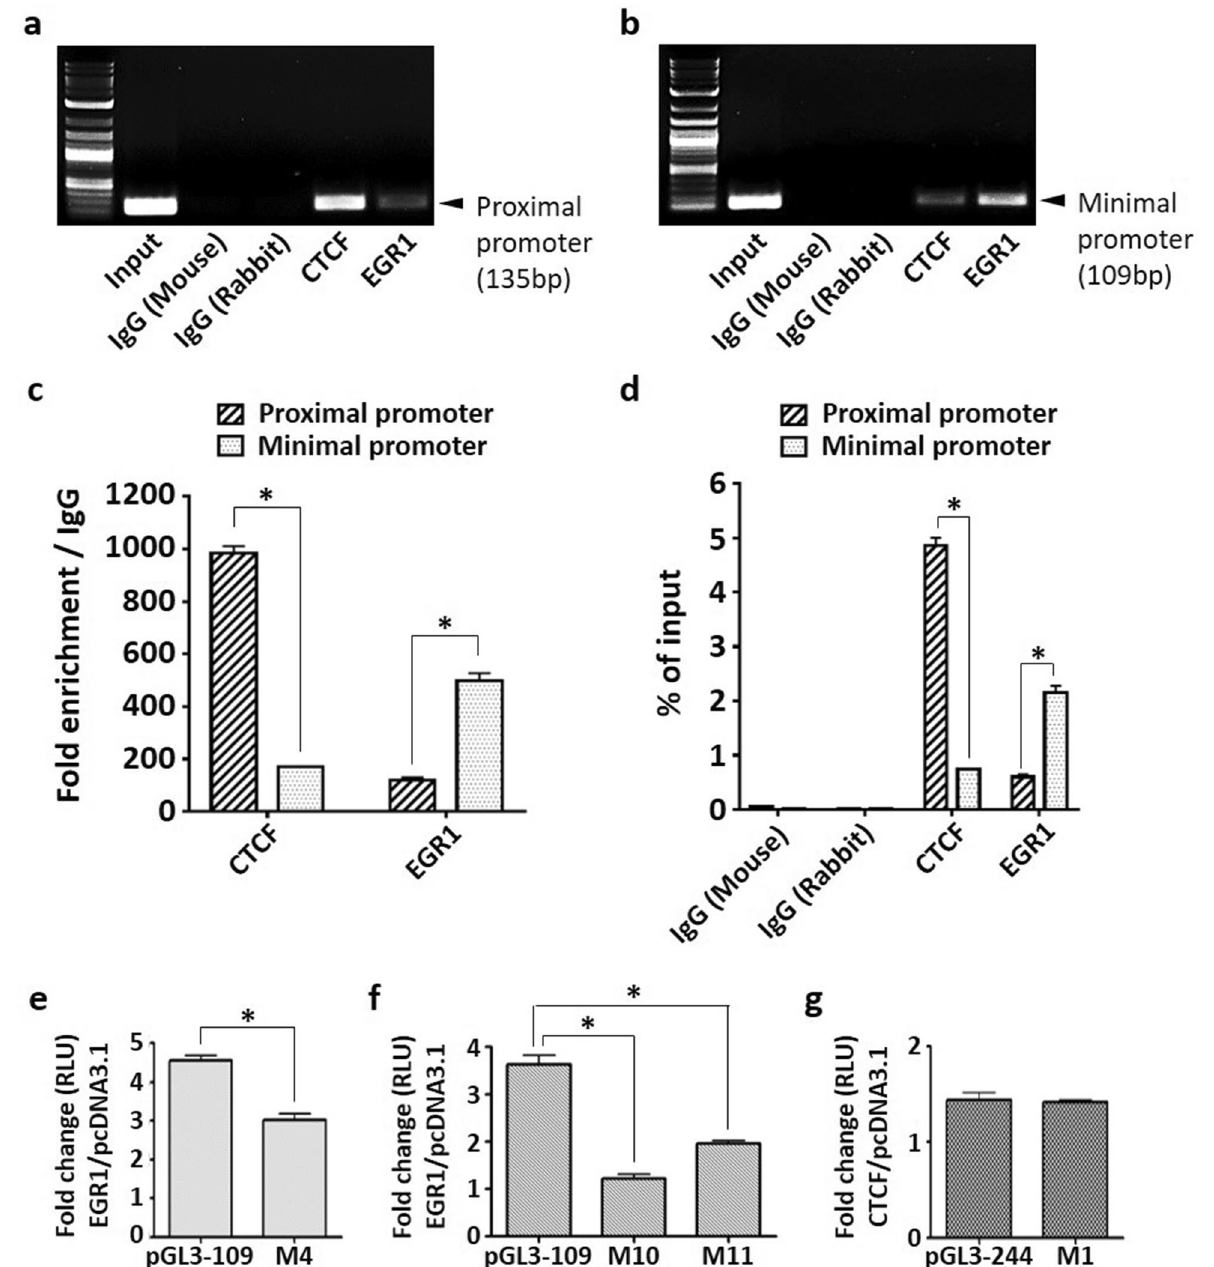
Figure 5. Binding of EGR1 to the NME1 proximal and minimal promoters in MCF-7 cells. Protein-DNA complexes were pulled down by primary antibodies and protein G agarose beads, followed by qPCR. DNA gel electrophoresis was performed to analyze the presence of ( a ) the 136 bp proximal promoter (− 244 to − 109 bp) and ( b ) the 109 bp minimal promoter (− 109 to − 1 bp). ‘Input’ is the chromatin collected before antibody incubation. IgG (Mouse) and IgG (Rabbit) serve as antibody isotype controls. Data are shown as a representative experiment from three independent experiments. ( c ) Fold enrichment was calculated as fold change of Ct over corresponding IgG isotype controls. ( d ) Percentage of Input was calculated using Ct value of Input that represents 1% of starting chromatin. ( e , f , g ) MDA-MB-231 cells were transiently transfected with CTCF or EGR1 and promoter mutants. Cells were lysed 48 h after transfection and luciferase assays were performed using the Dual-Luciferase Reporter Assay System (Promega). Fold change was calculated as the increase in promoter activity by EGR1 or CTCF relative to pcDNA3.1 control. Data represent the mean and standard deviation of three independent trials. *p <